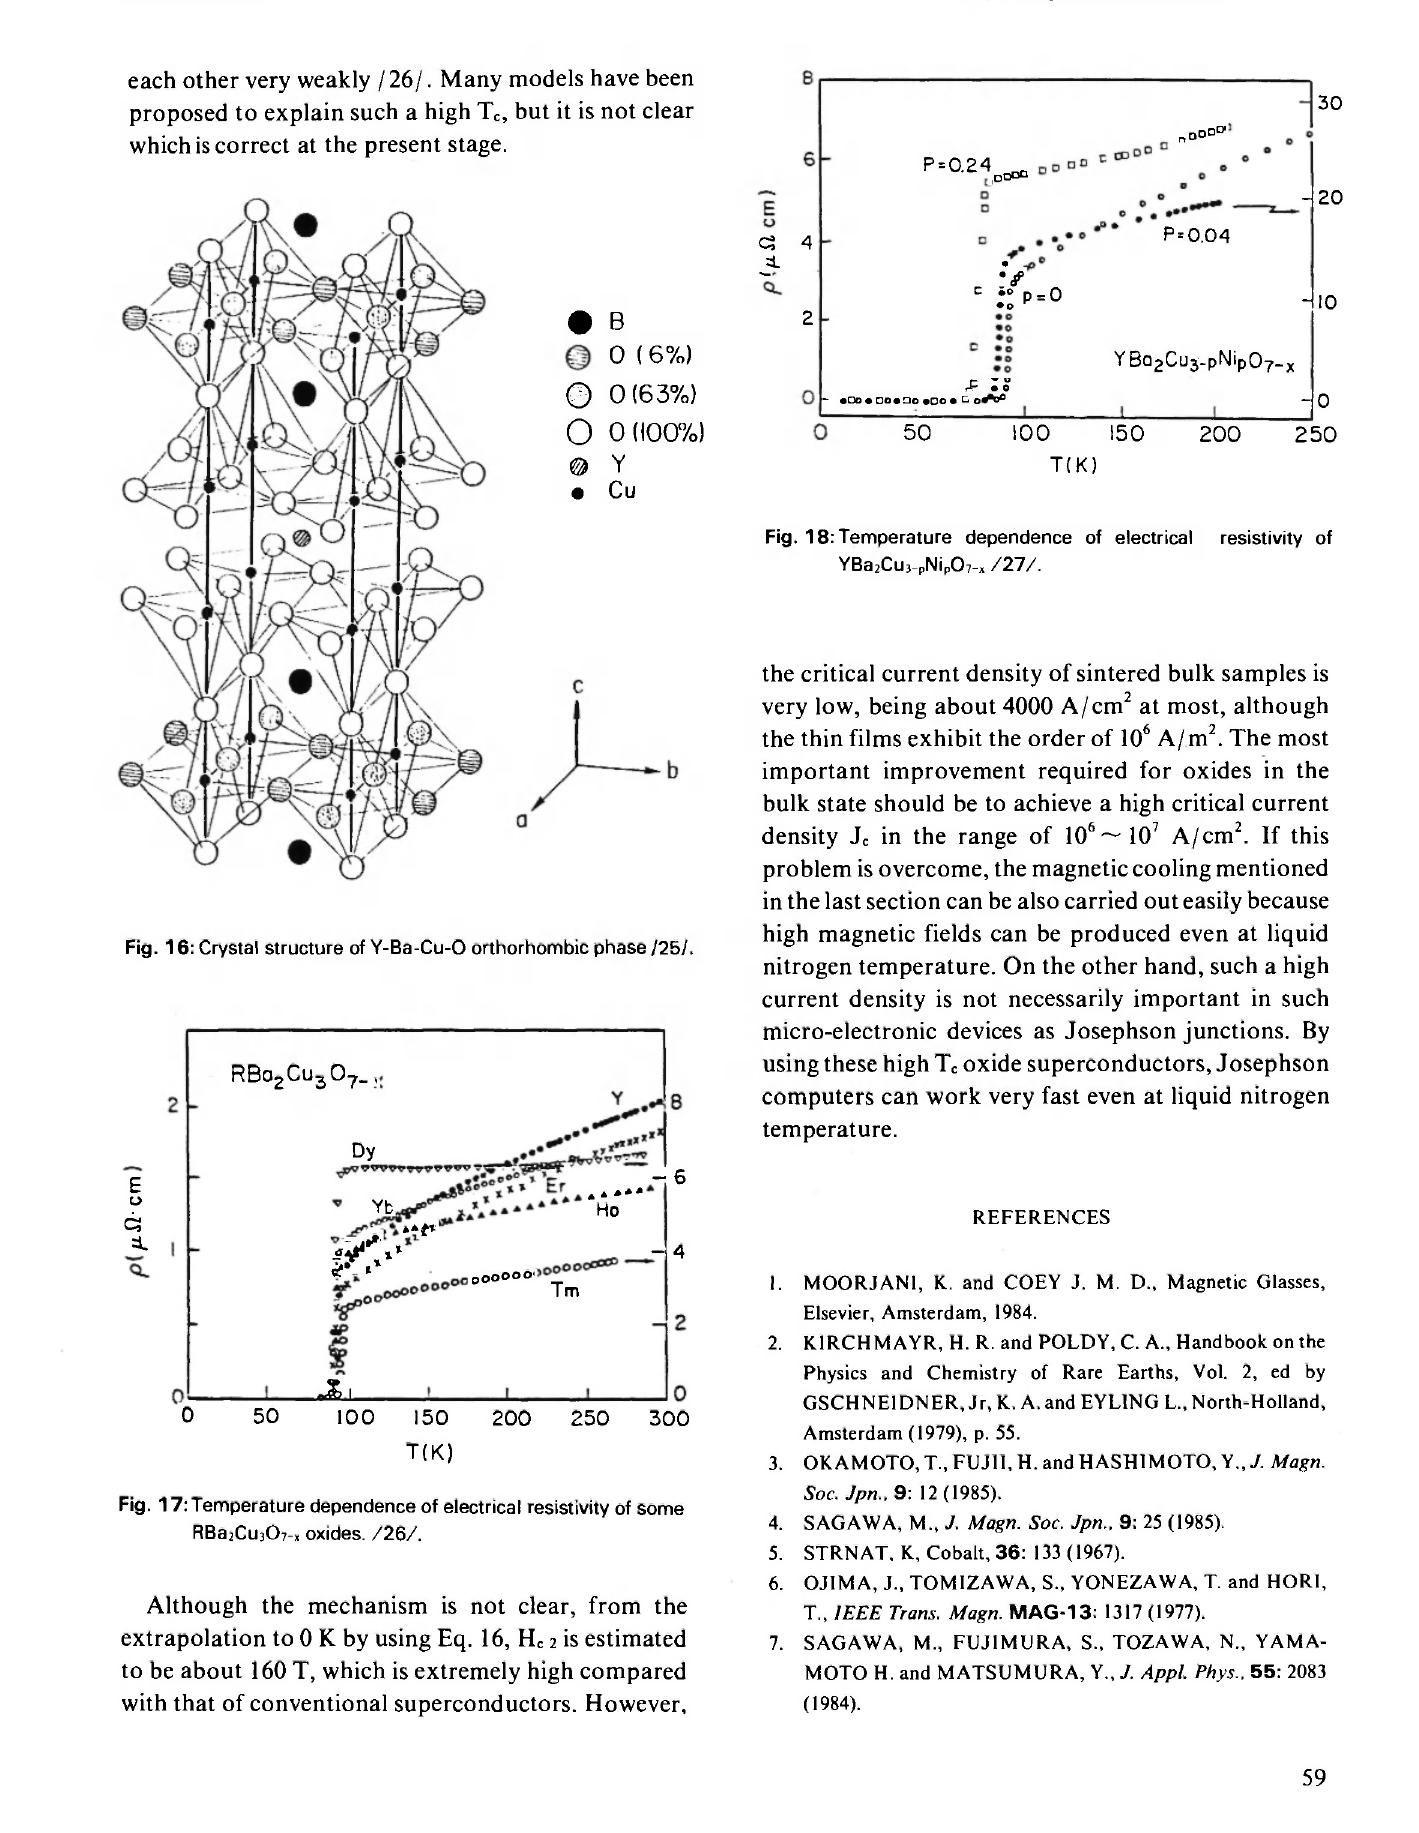
Fig. 17: Temperature dependence of electrical resistivity of some RBajCujO?-x oxides. /26/.